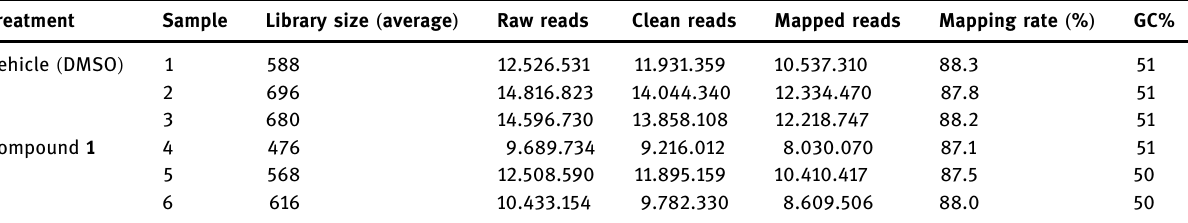
Table 2: Summary of RNA - seq data including library construction, sequencing, and mapping results